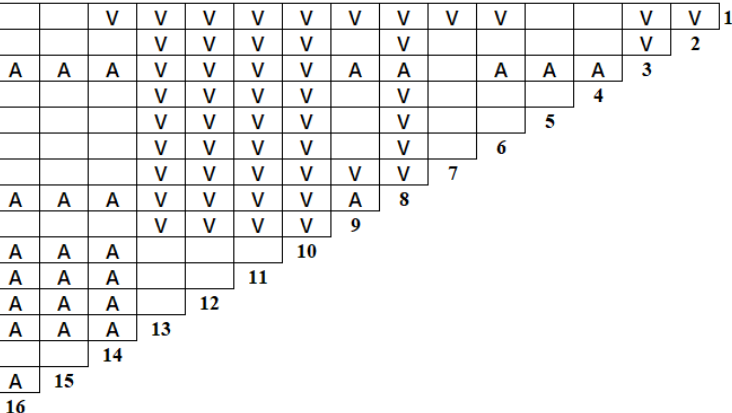
Figure 6. Box plot of the interactions between the brittleness factors of lean–green manufacturing systems in the context of Industry 4.0. Table 6. The reachable matrix of factors influencing the brittleness of lean–green manufacturing systems in the context of Industry 4.0.